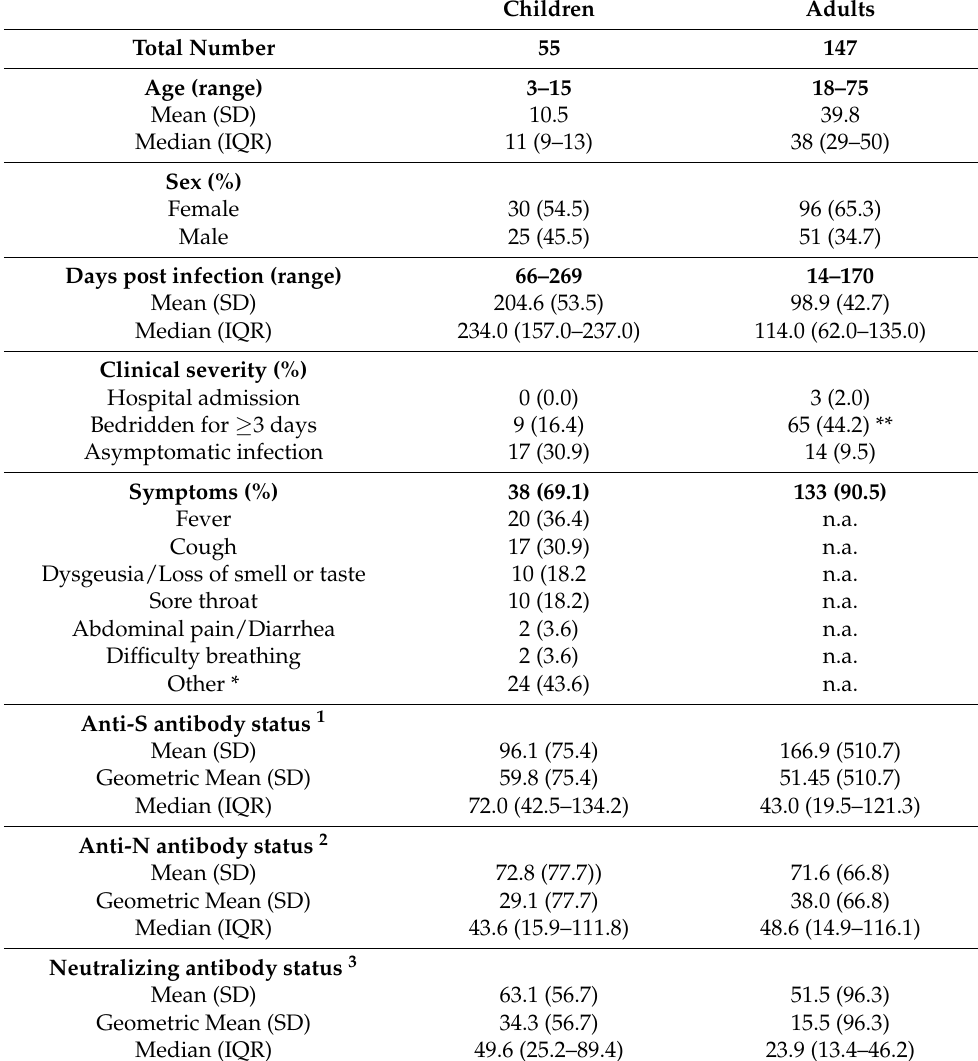
Table 2. Humoral response and disease characteristics in PCR confirmed § cases children vs.